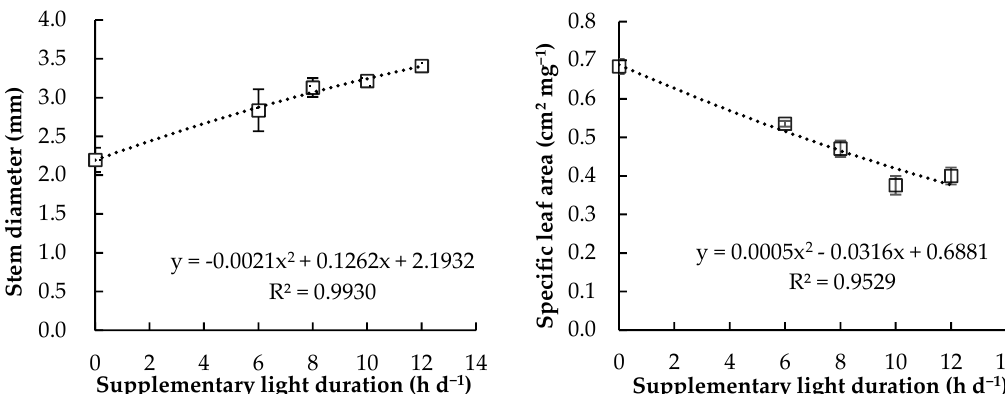
Figure 2. Relationships between supplementary light duration with the same daily light integral and morphological characteristics of cucumber seedlings grown in the greenhouse for 21 days after